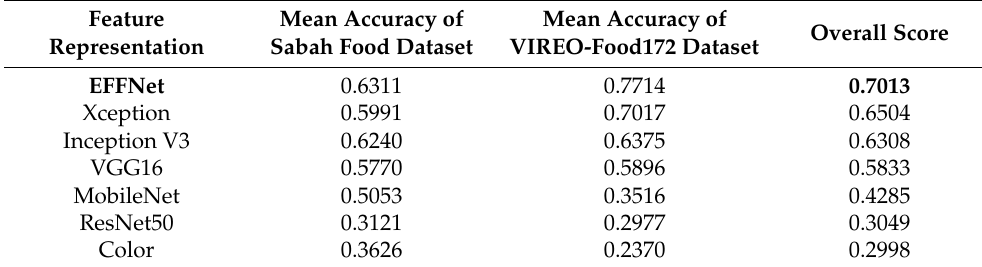
Table 22. The overall performance of all feature